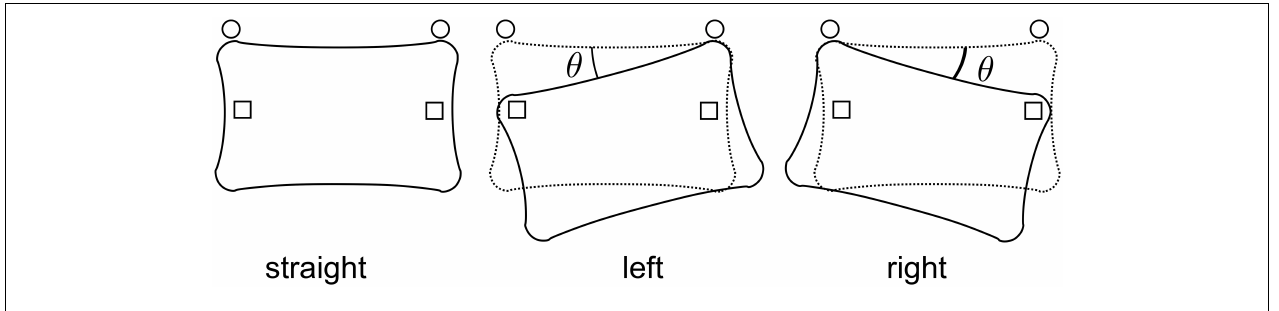
FIGURE 2 | Body orientation manipulation: the WBB was set at three different angles. Circles and squares in the figure represent the markers placed on the floor. Because the board was manually